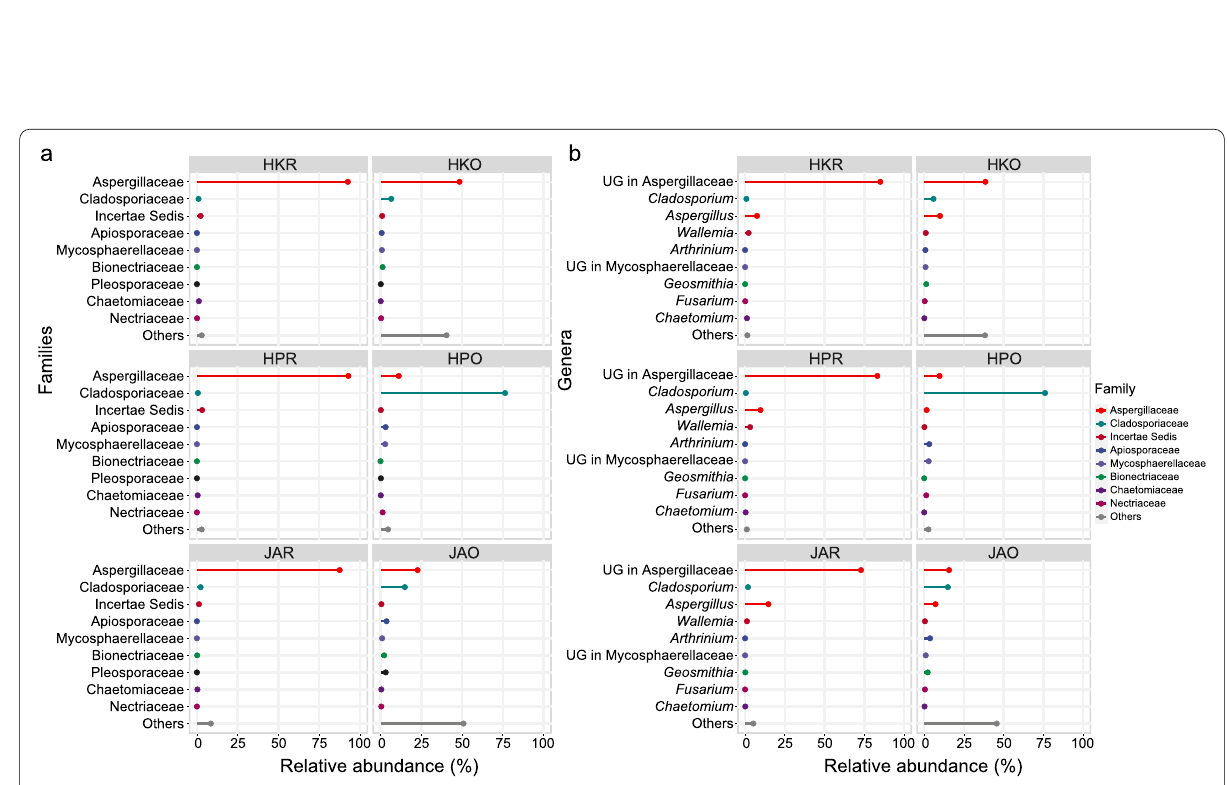
Fig. 2 Relative abundance of fungi at family (a) and genus (b) levels at six sampling sites (waste reception halls of three transfer stations: HKR, HPR, JAR; top vents of three transfer stations: HKO, KPO, JAO). Genera belonging to the same family are represented by the same color as shown in the legend. UG: Unclassified